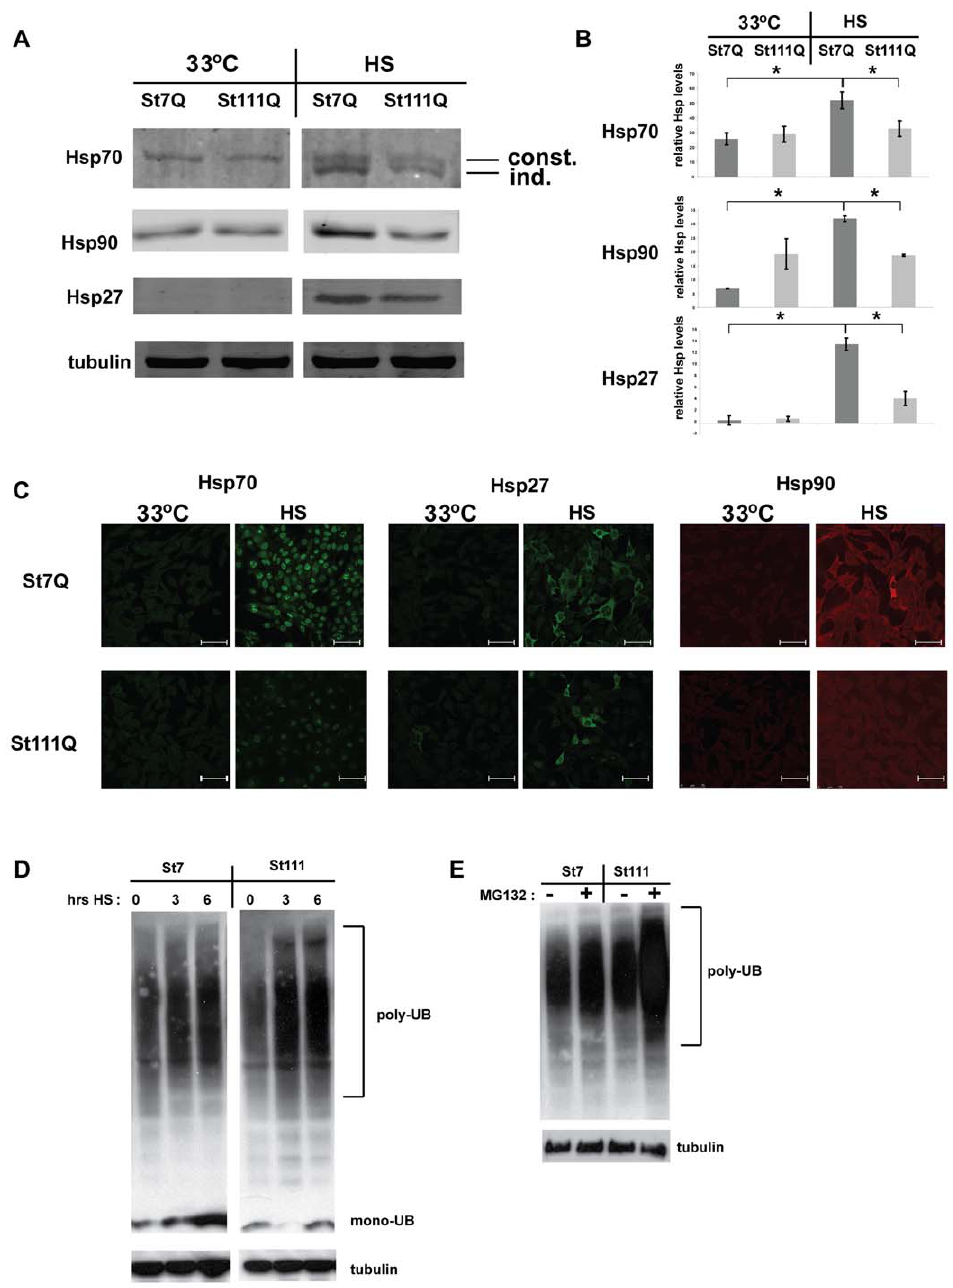
Figure 2. Impaired heat shock response in cells expressing polyQ-expanded Htt. A ) Western blots were prepared with protein lysates from STHdh(Q7) (St7Q) and STHdh(Q111) (St111Q) cells that were grown at 33 u C or heat shocked (HS), i.e. grown at 33 u C and then incubated at 42 u C for three hours. The blots were probed with the indicated anti-Hsp antibodies and anti-tubulin antibodies as a loading control. The anti-Hsp70 antibody (3A3) detects both constitutive (const.) and inducible (ind.) Hsp70s. B ) Quantification of Western blots as shown in Figure 1 A. All signals were normalized to the corresponding tubulin signal in each experiment. For Hsp70, both the constitutive and the inducible Hsp70s were quantified together. The error bars present SDs. * p , 0.01 (two-tailed t-test). C ) Immunofluorescence microscopy of fixed cells that were grown at 33 u C and heat shocked cells (HS, three hours at 42 u C) using the indicated anti-Hsp antibodies. The scale bars represent 75 m m D ) Western blot probed with an anti- ubiquitin antibody of protein lysates derived from STHdh(Q7) and STHdh(Q111) cells that were grown at 33 u C or exposed to a heat shock (42 u C) for either three or six hours. A western blot using an anti-tubulin antibody (bottom) served as a loading control. E) Western blot probed with an anti- ubiquitin antibody of protein lysates derived from STHdh(Q7) and STHdh(Q111) cells that were grown at 33 u C in the absence or presence of 10 m M MG132. A western blot using an anti-tubulin antibody (bottom) served as a loading control. doi:10.1371/journal.pone.0037929.g002 cells showed more diffuse Hsp70 staining in the nucleus and the cytosol. This nuclear granular Hsp70 staining (Figure 4 B) may be